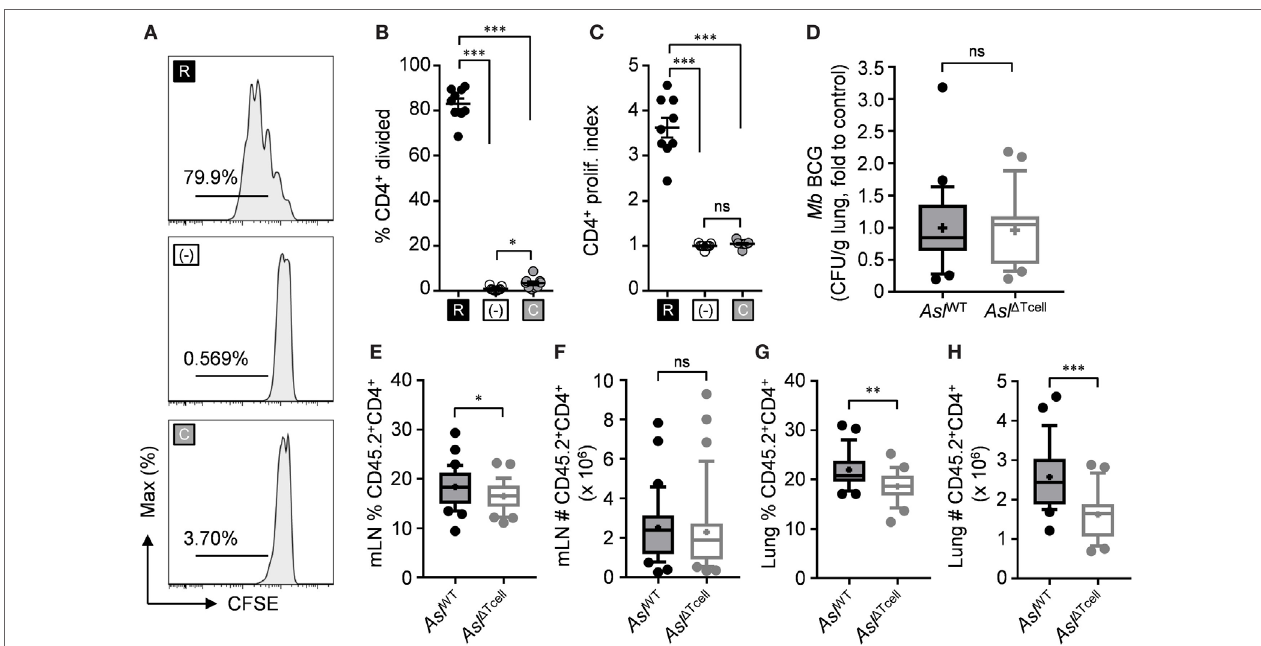
FigUre 6 | l - c itrulline metabolism is necessary for CD4 + T cell accumulation in the mycobacterial infected lung and mediastinal lymph node in vivo . (a–c) Lymphocytes from Asl flox/flox ;CD4-cre ( Asl Δ Tcell ) were isolated and stained with carboxyfluorescein succinimidyl ester (CFSE). Cells were stimulated with α -CD3 in R-free RPMI supplemented with 1 mM l -arginine (black), 1 mM l -citrulline (gray), or neither amino acid added (white) for 72 h. CFSE dilution of CD3 + CD4 + T cells was analyzed by flow cytometry. Data are displayed as representative histograms (a) , percent of divided cells (B) , and by proliferation index (c) as defined in the methods. Data are combined from three experiments. (D–h) Asl flox/flox ( Asl WT ) and Asl Δ Tcell mice were infected with ~5 × 10 6 colony forming unit M. bovis BCG intranasally. Eight weeks postinfection, mycobacterial burden was quantified in the lungs (D) . CD45.2 + CD4 + cells were quantified from the mediastinal lymph node (e,F) and infected lung (g,h) . Data are combined from three experiments and are displayed as box and whisker plots ( n ≥ 22). Error bars, SEM. * p < 0.05, ** p < 0.01, *** p < 0.001 by Student’s t